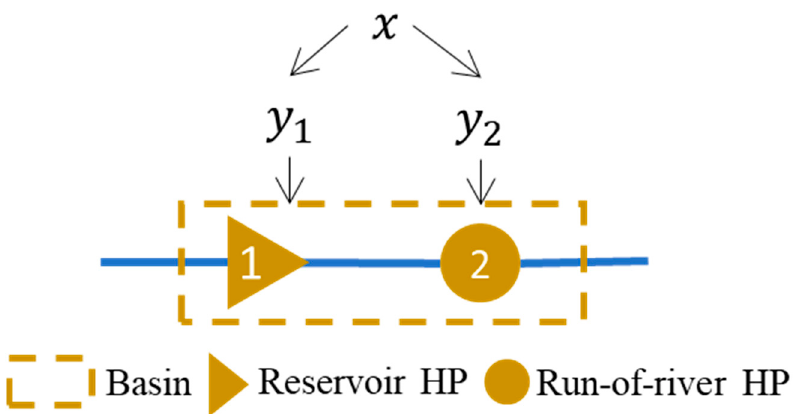
Figure 2. Cascaded hydropower plants.